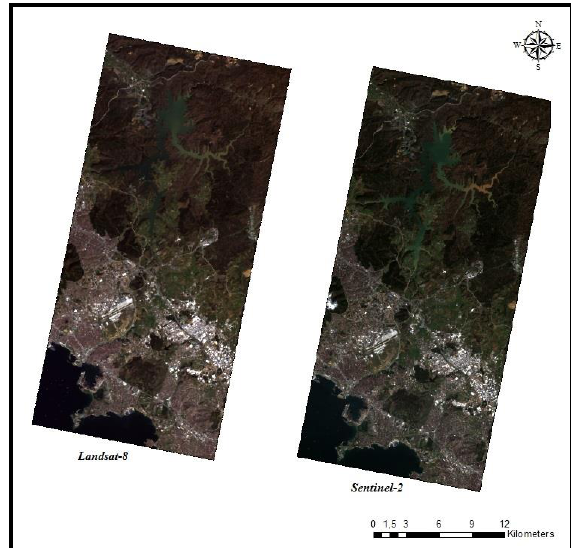
Figure 3. Landsat-8 and Sentinel-2 with 6 multispectral bands. Both satellite images were converted to Top-of-Atmosphere reflectance values. Atmospheric correction was not necessary because these images were quite clear within the study area. Landsat-8 and Sentinel-2 images were acquired as geometrically corrected and both images are in Universal Transform Mercator (UTM) coordinate system and World Geodetic System (WGS- 84, Zone 35) and geometrically matching each other with sub- pixel